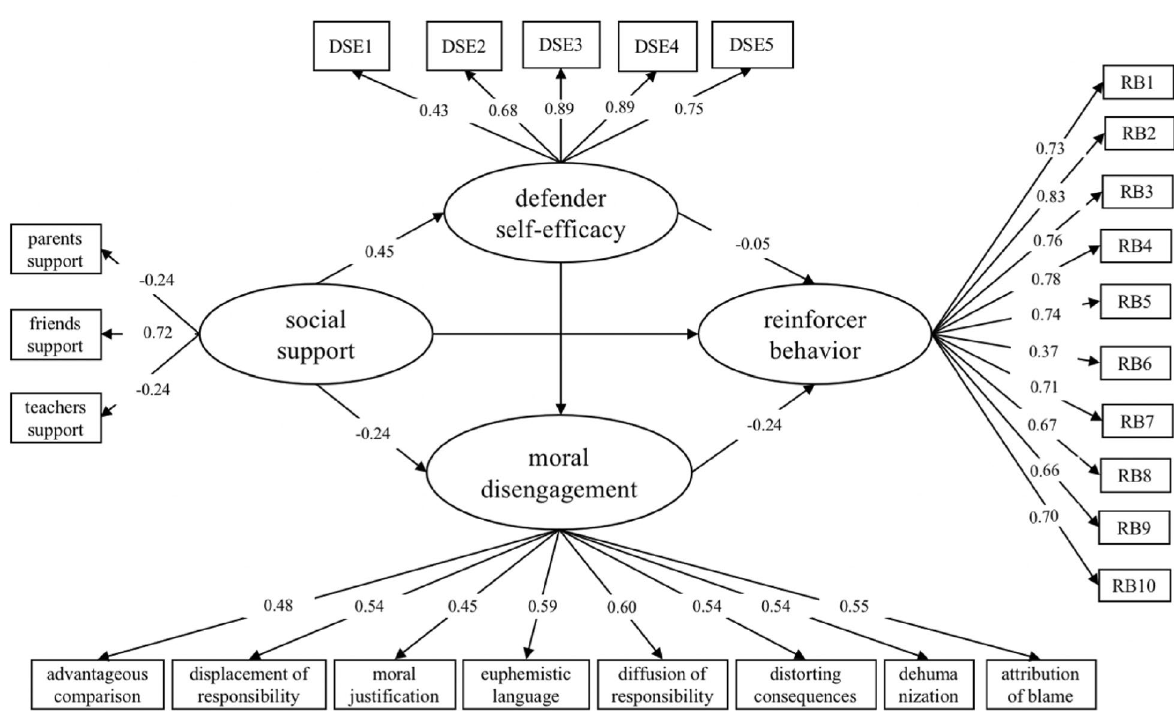
Fig. 2 The mediating effect of defender self-efficacy and moral disengagement in the relationship between social support and reinforcer